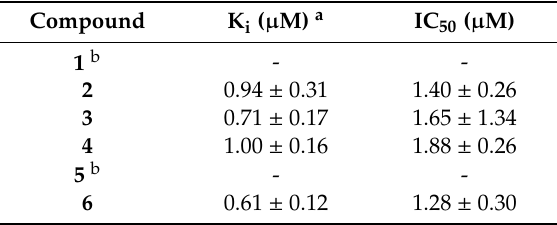
Table 1. K i and IC 50 values of candidate compounds.